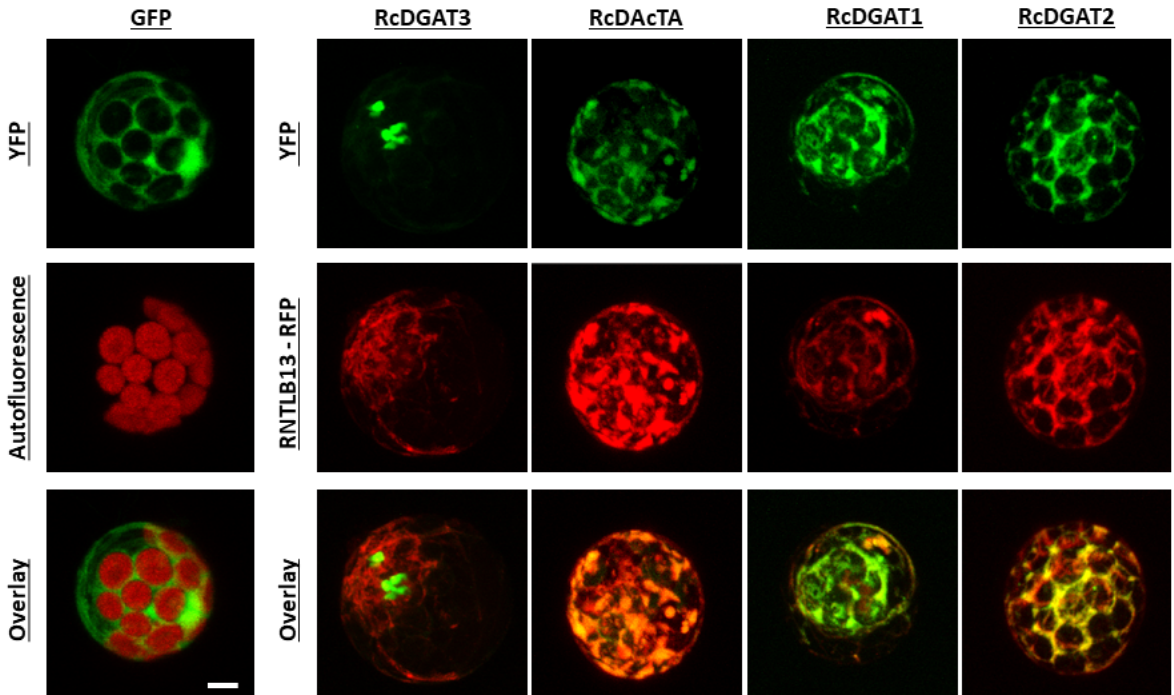
Figure 2 – Subcellular localization of castor bean acyltransferases. Protoplasts from Arabidopsis mesophyll cells transiently expressing GFP, RcDGAT3- YFP, RcDAcTA-YFP, RcDGAT1-YFP, or RcDGAT2-YFP. The left panel shows the fluorescence of GFP alone and the chloroplasts autofluorescence (red), as well as the overlay of both images. The right panel shows the fluorescence of RcDGAT proteins translationally fused with YFP, the fluorescence of the endoplasmic reticulum protein marker RNTLB13-RFP (in red), and the overlay of both images (last line). Scale bar = 5